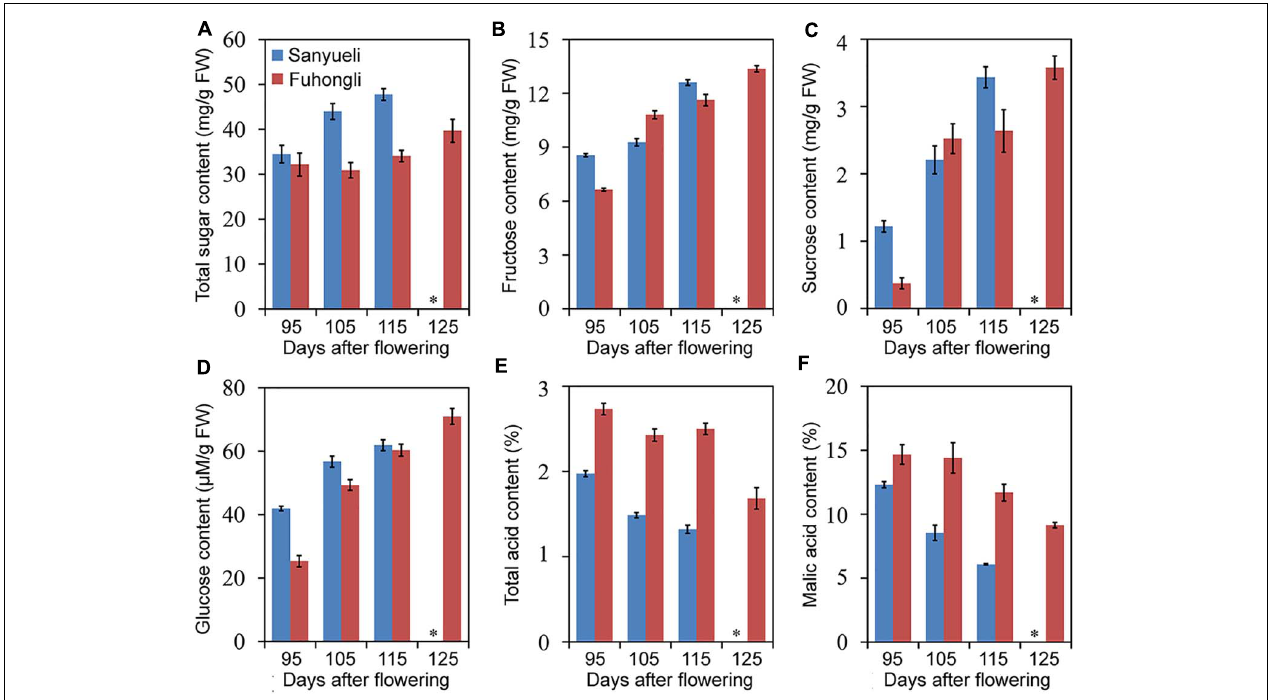
FIGURE 1 | Trends in total soluble sugar (A) , fructose (B) , sucrose (C) , glucose (D) , total acid (E) , and malic acid (F) content in the flesh of ‘Sanyueli’ and ‘Fuhongli’ plum during fruit ripening. ∗ indicates there is no value for ‘Sanyueli’ 125 DAF as the fruits ripened earlier. Error bars represent standard error of three